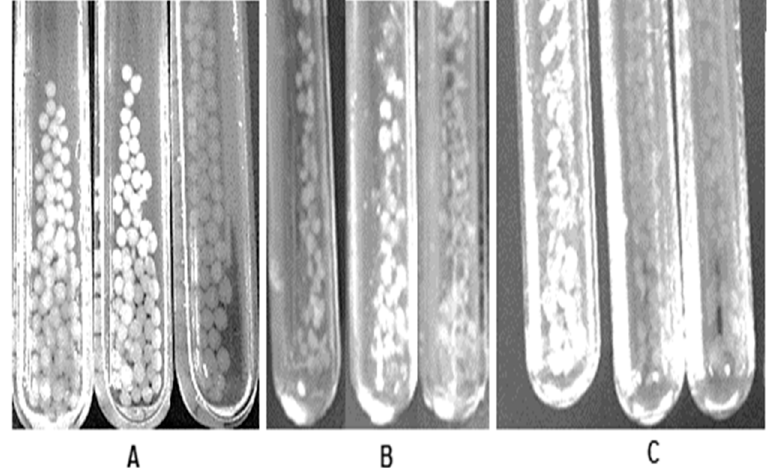
Figure 3. Images of f4 capsules during digest phases: ( A ) SA-AG, ( B ) SA-CO, and ( C ) SA-GE. From left to right: initial capsules, at the end of oral phase, at the end of gastric phase.